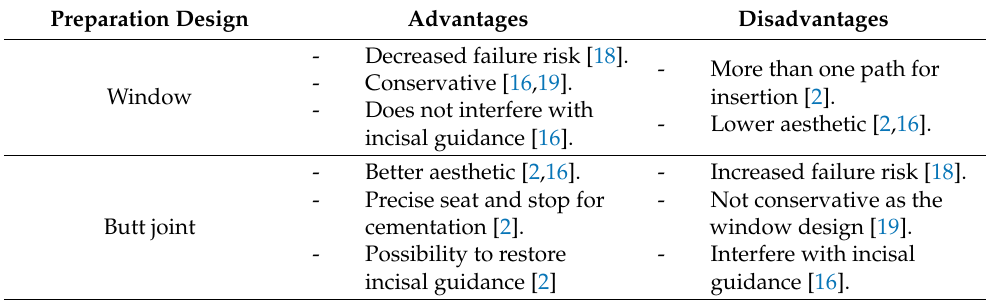
Table 5. Advantages and disadvantages between window and butt joint designs for laminate veneers. Preparation Design Advantages